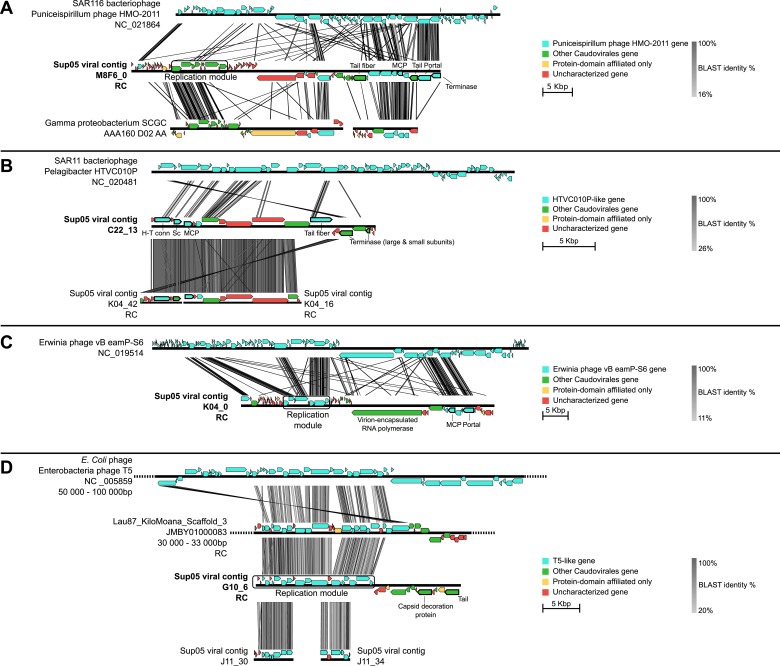
Genetic map and synteny plots for the four references SUP05 Caudovirales contigs M8F6_0 (A), C22_13 (B), K04_0 (C) and G10_6 (D) (highlighted in bold).Viral hallmark genes are underlined and identified on plots (MCP: major capsid protein, Sc: scaffolding protein, H-T conn.: head-tail connector). Sequence similarities were deduced from a tBLASTx comparison. For clarity sake, several sequences including SUP05 viral contig M8F6_0, K04_0, and G10_6 are reverse-complemented (noted RC).DOI:
http://dx.doi.org/10.7554/eLife.03125.00810.7554/eLife.03125.009Figure 2—source data 1.Summary of best BLAST hit affiliation for the predicted genes of the five SUP05 reference viral contigs.For each contig, taxonomic and functional affiliation are indicated with the group or category and the number of genes affiliated to this group. The category ‘virion formation’ includes all genes associated to the formation of the capsid and the genome encapsidation.